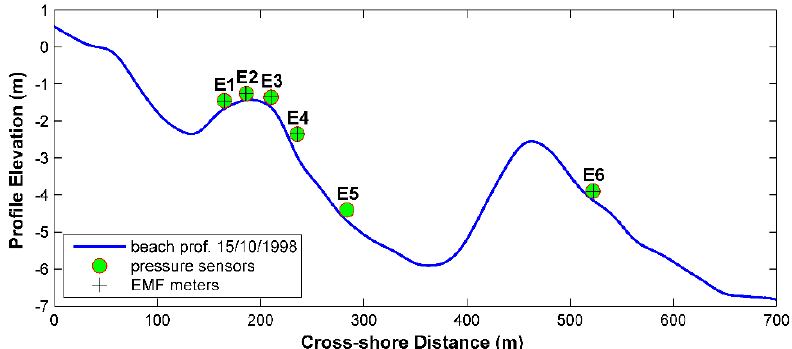
Figure 2. Beach topography and measured locations at Egmond Beach, the Netherlands.